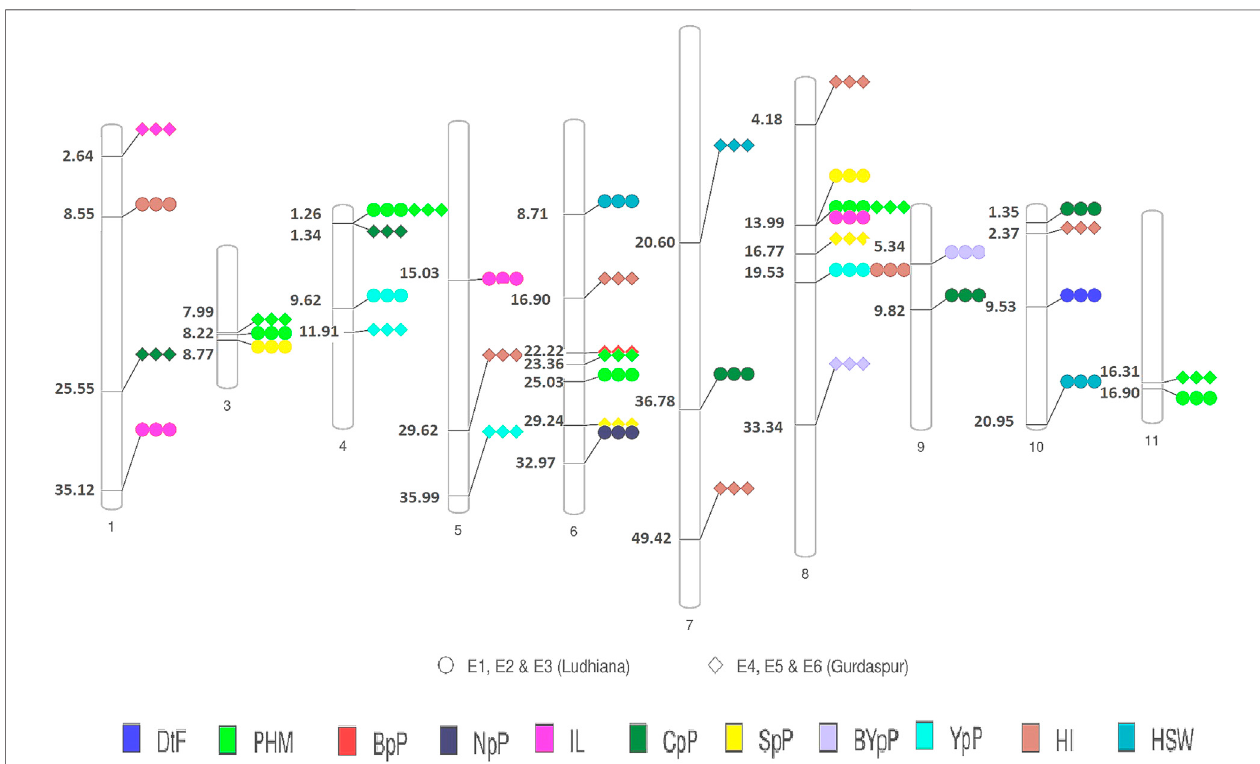
FIGURE 5 | Physical map of QTLs of different traits detected by GWAS in the present study. Circles represent detection of across different environments at Ludhianaanddiamonds representdetectionofacrossdifferentenvironmentsatGurdaspur ## Daysto50% fl owering(DtF);Daysto90%podmaturity(DtM);Plantheight at 90% pod maturity (PHM); Nodes per plant (NpP); Internodal length (IL), Clusters per plant (CpP); Pods per plant (PpP); Seeds per pod (SpP); Biological yield per plant (BYpP); Yield per plant (YpP); hundred seed weight (HSW) and Harvest index (HI).